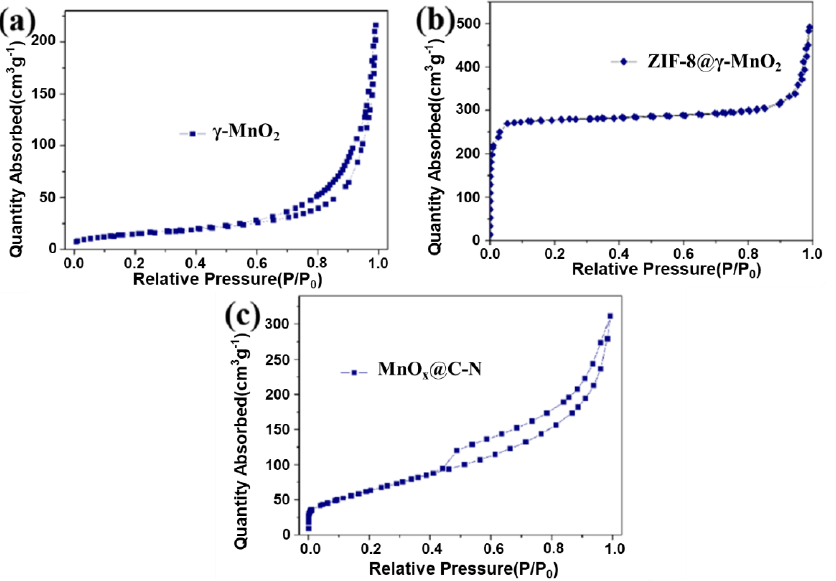
Figure 5. N 2 physisorption isotherms for the catalyst. ( a ) γ -MnO 2 ; ( b ) ZIF- 8@γ -MnO 2 ; and ( c )